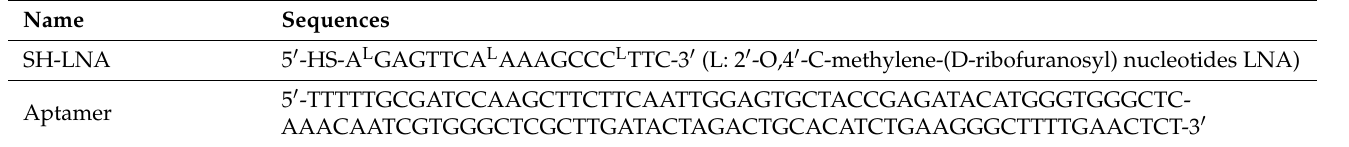
Table 2. Details of the SH-LNA and SE